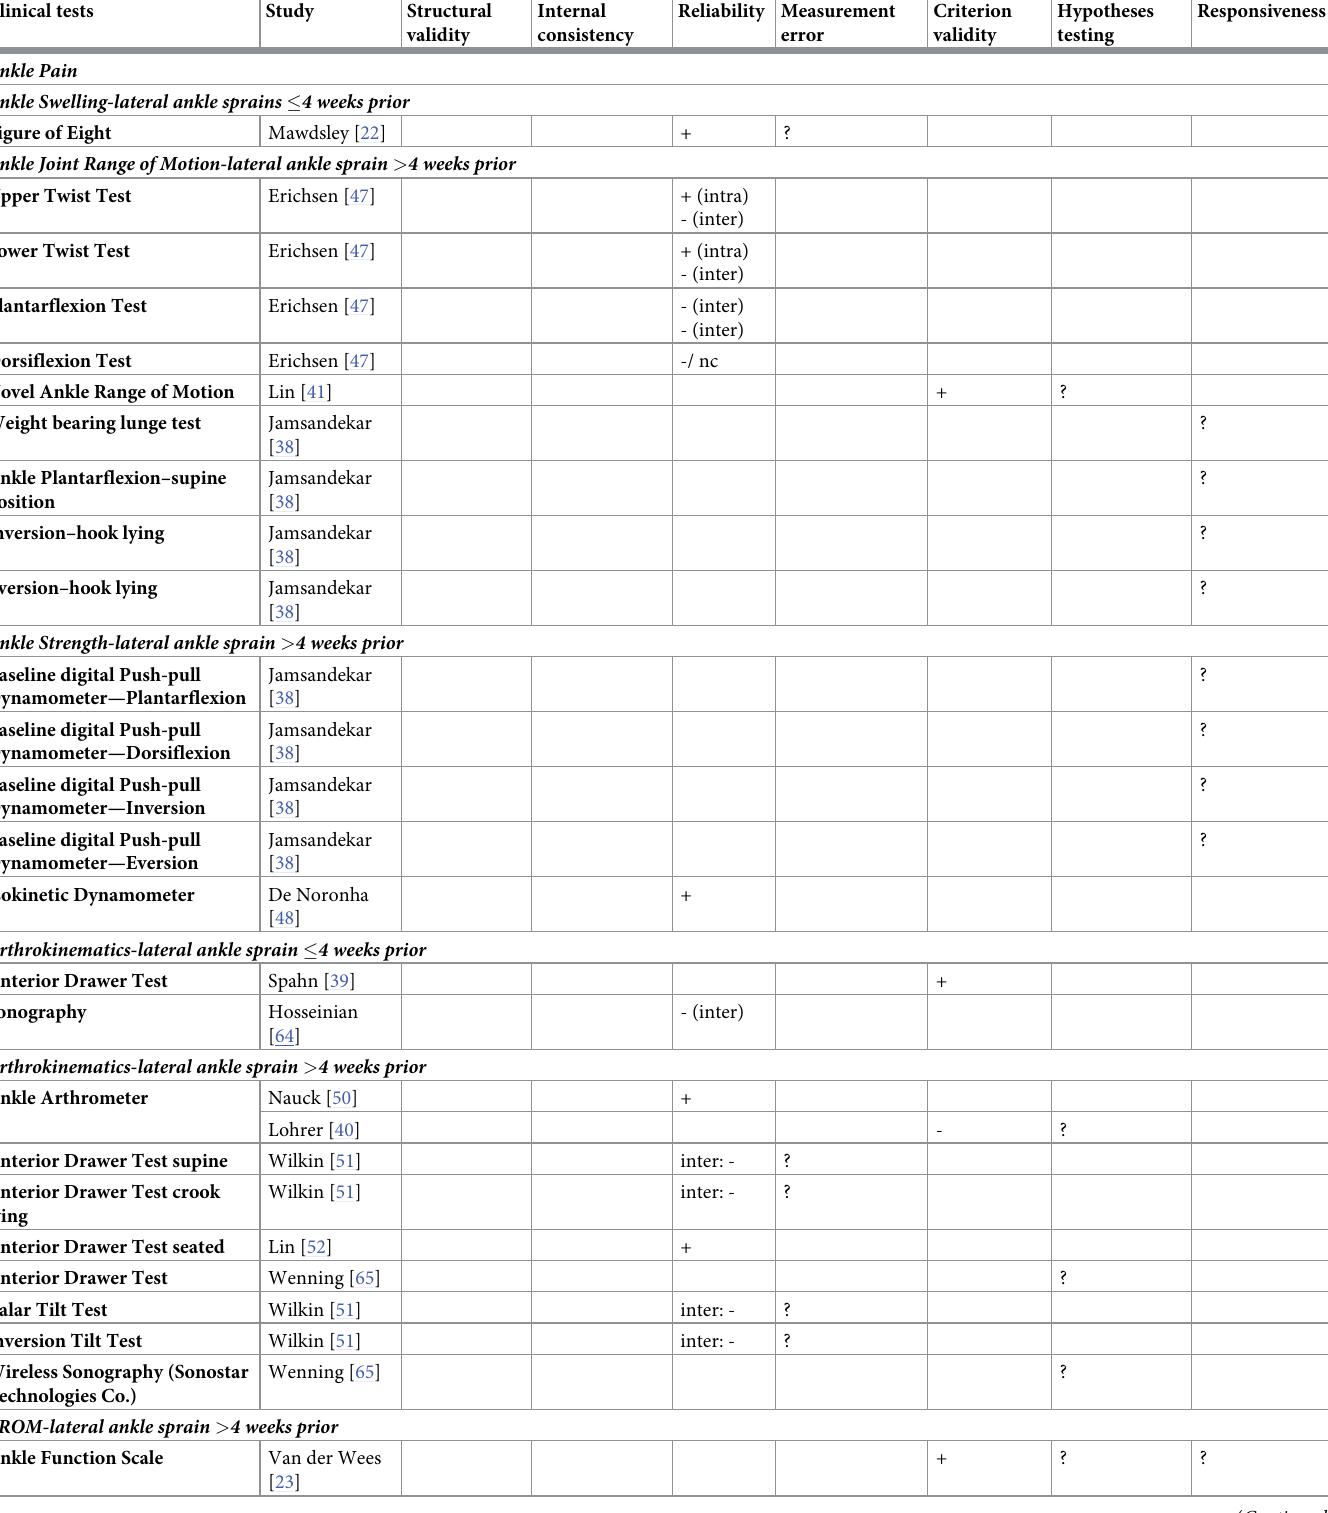
Table 4. Overview table of study results: Primary